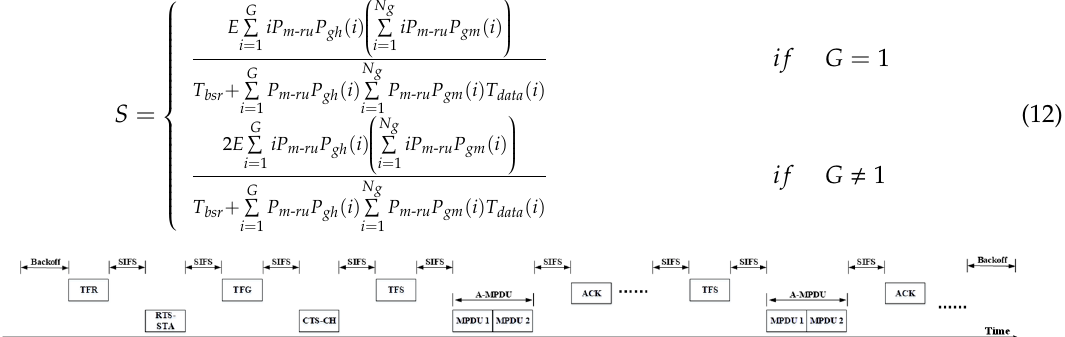
Figure 3. Transmission time mechanism of GFDO protocol.